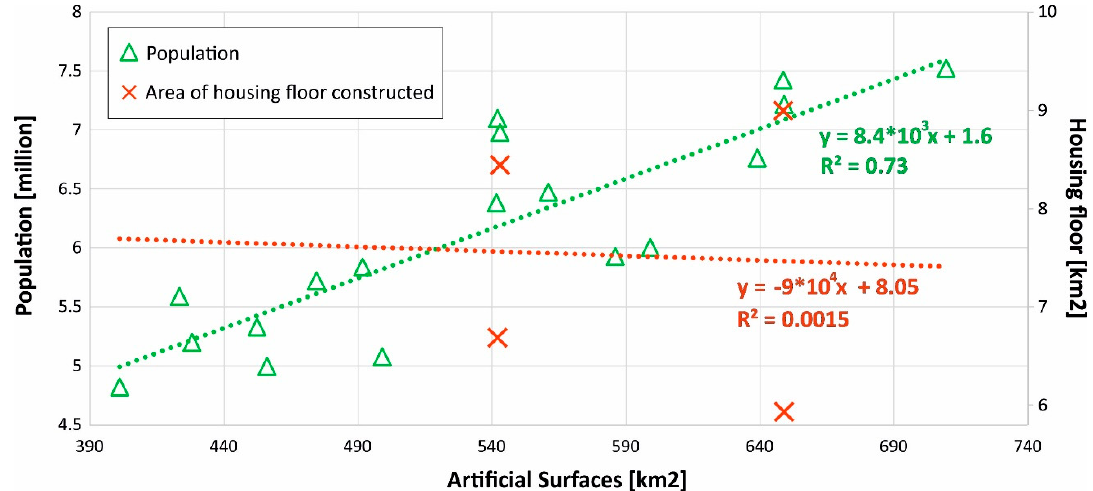
Figure 6. Correlation between artificial surfaces vs population (green) and housing floor construction (red). Linear fitting and R 2 values for each variable are provided.